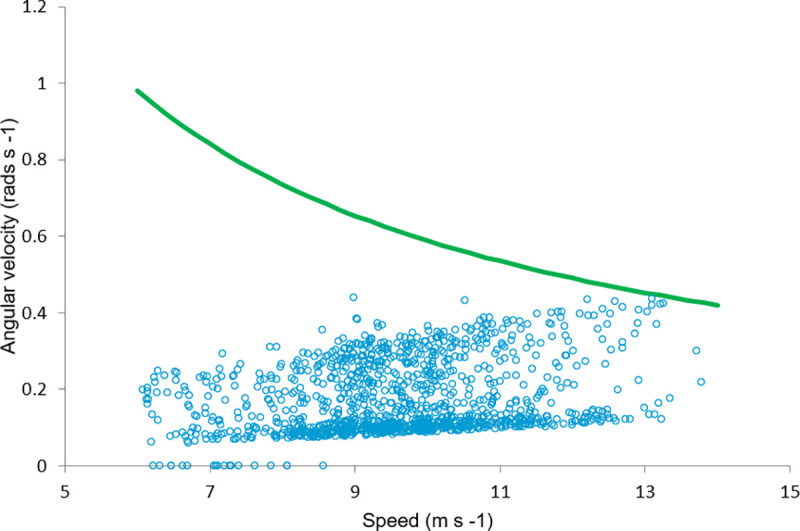
Friction affects smaller turns at higher speeds.Angular velocity plotted against speed for each stride collected. The green line represents the cutoff for speed at a given angular velocity based on a coefficient of friction (μ) of 0.6, as described by Tan & Wilson [2].